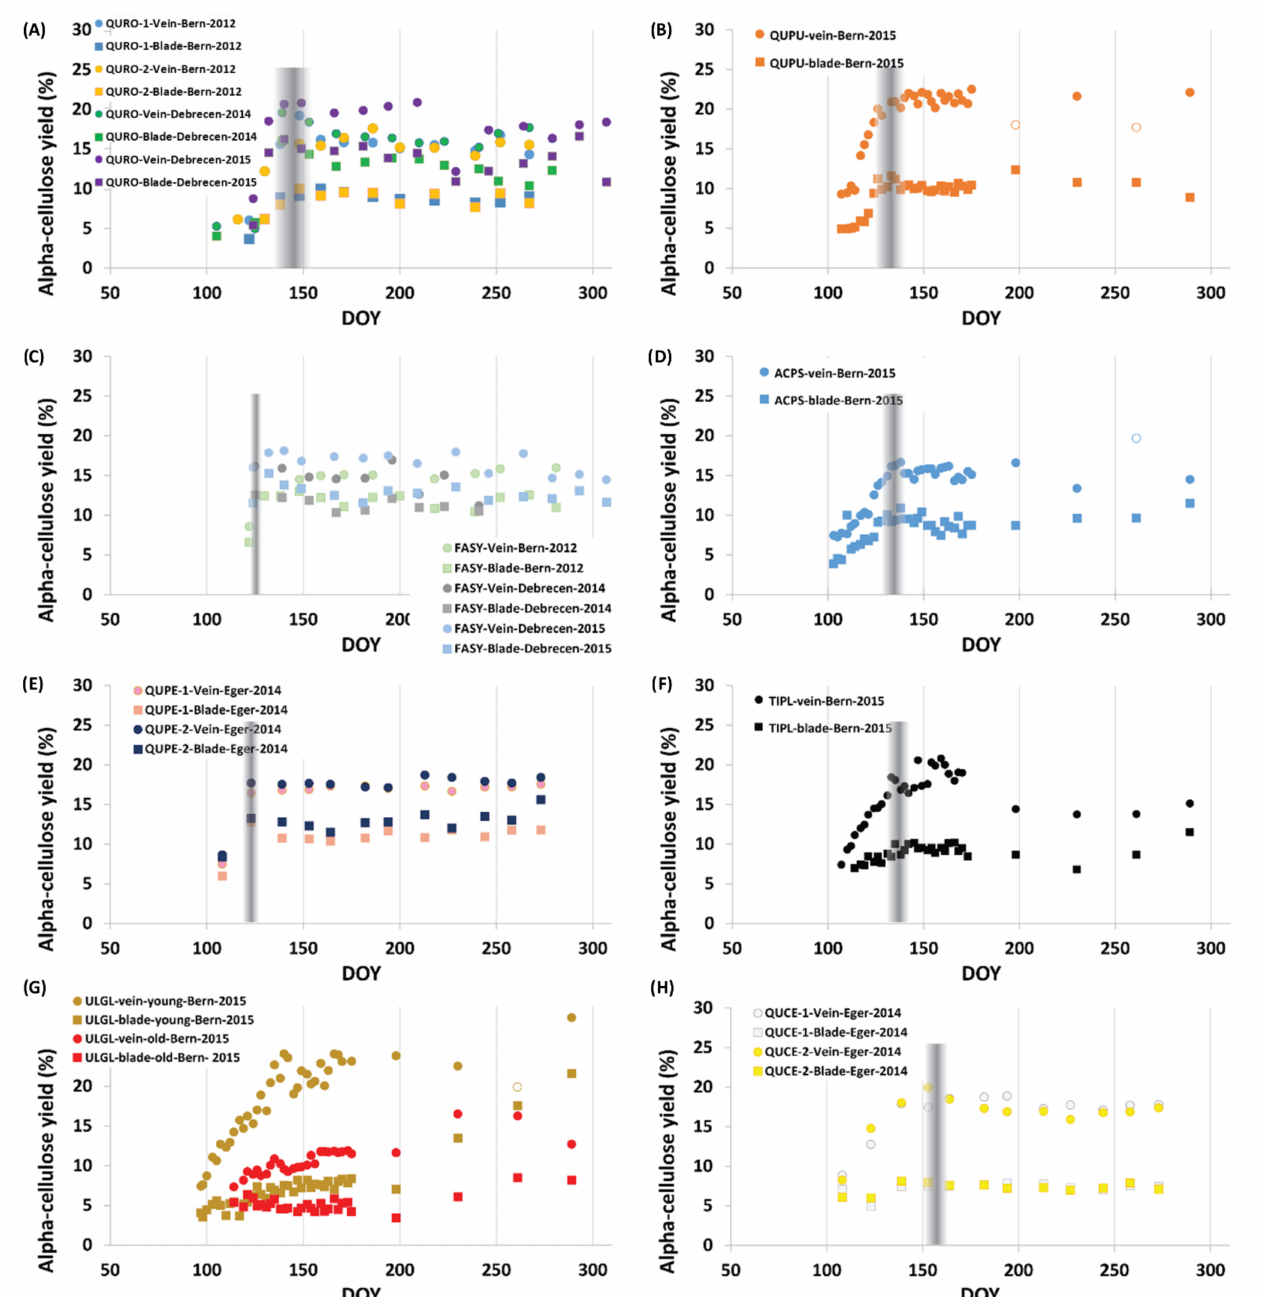
Figure 1. Seasonal distribution of alpha-cellulose yields of leaf samples of eight broadleaf species. ( A ) pedunculate oaks ( Quercus robur L.), ( B ) pubescent oak ( Quercus pubescens Wild.), ( C ) European beech ( Fagus sylvatica L.), ( D ) sycamore maple ( Acer pseudoplanatus L.), ( E ) sessile oaks ( Quercus petraea (Matt.) Liebl.), ( F ) Large-leaved lime ( Tilia platyphyllos Scop.), ( G ) Scots elm ( Ulmus glabra Huds.), ( H ) Turkey oak ( Quercus cerris L.). Colored-in squares and circles denote blades and veins, respectively, while the empty symbols indicate potential cellulose extraction failures. Ordinate and abscissa represent the alpha-cellulose yields in percentage and the Day of Year (DOY), respectively. The gray shading indicates the transition from the juvenile to the mature